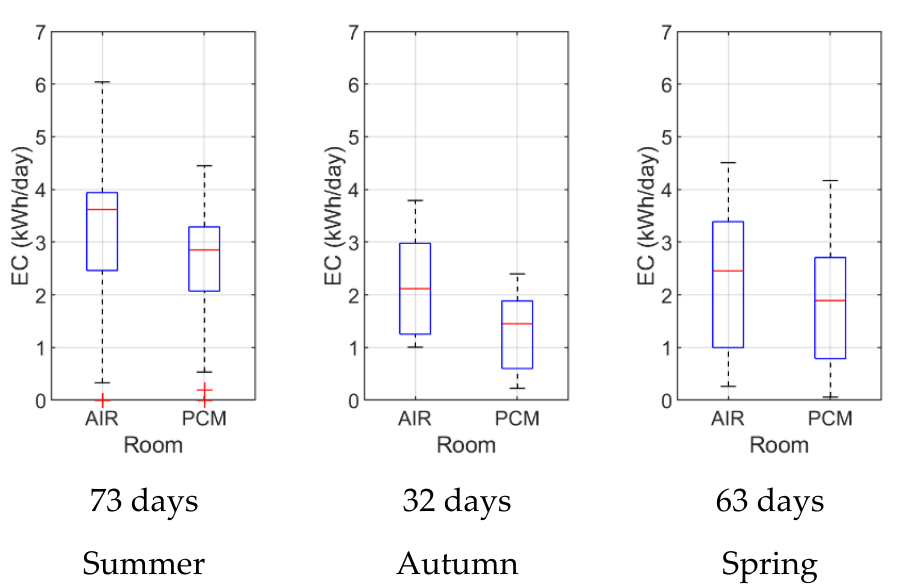
Figure 6. Seasonal result of daily energy consumption (EC). Winter is not included because of insufficient days with valid data.